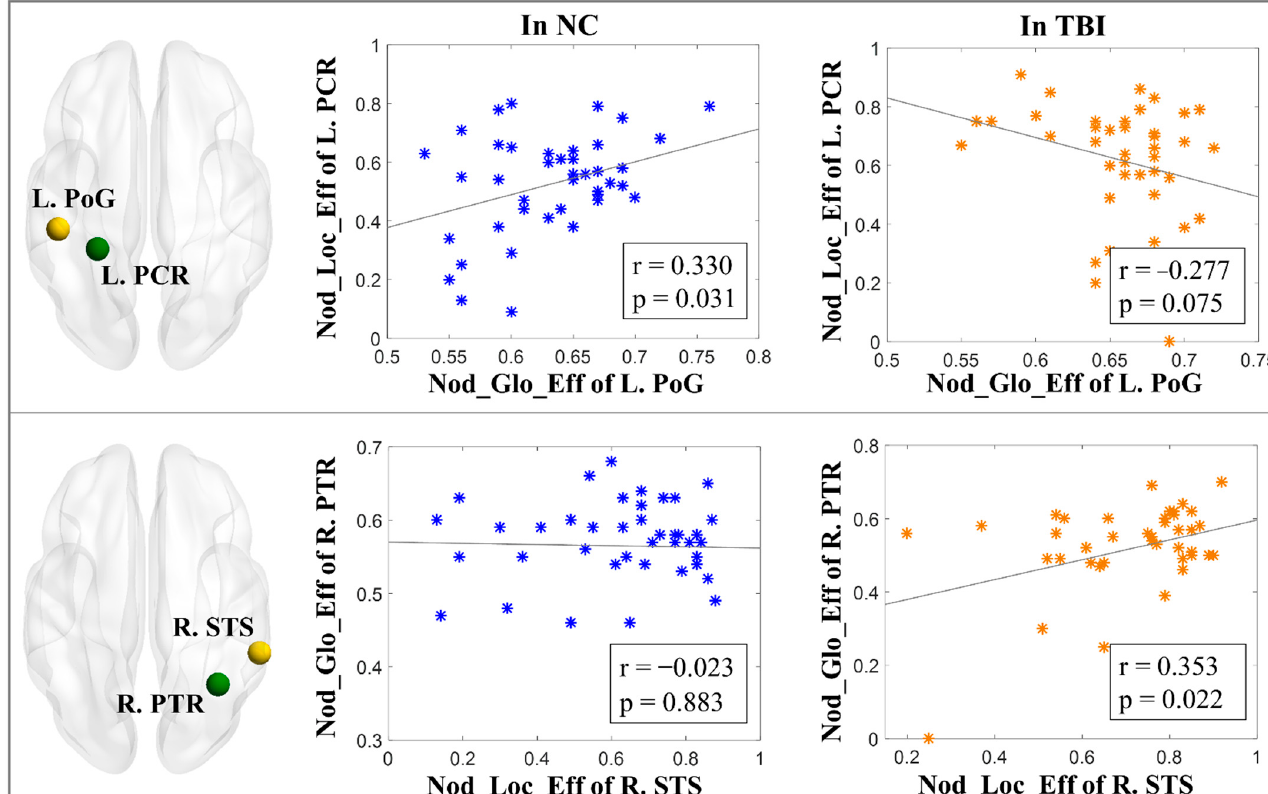
Figure 2. Interactions of white matter (marked in green) vs. gray matter (marked in yellow) network topological properties in the groups of NC and TBI. (NC: normal control; TBI: traumatic brain injury; r: correlation coefficient; p : level of significance; L.: left hemisphere; R.: right hemisphere; PoG: postcentral gyrus; PCR: posterior corona radiata; STS: superior temporal sulcus; PTR: posterior thalamic radiation; Nod_Loc_Eff: nodal local-efficiency; Nod_Glo_Eff: nodal global-efficiency.)